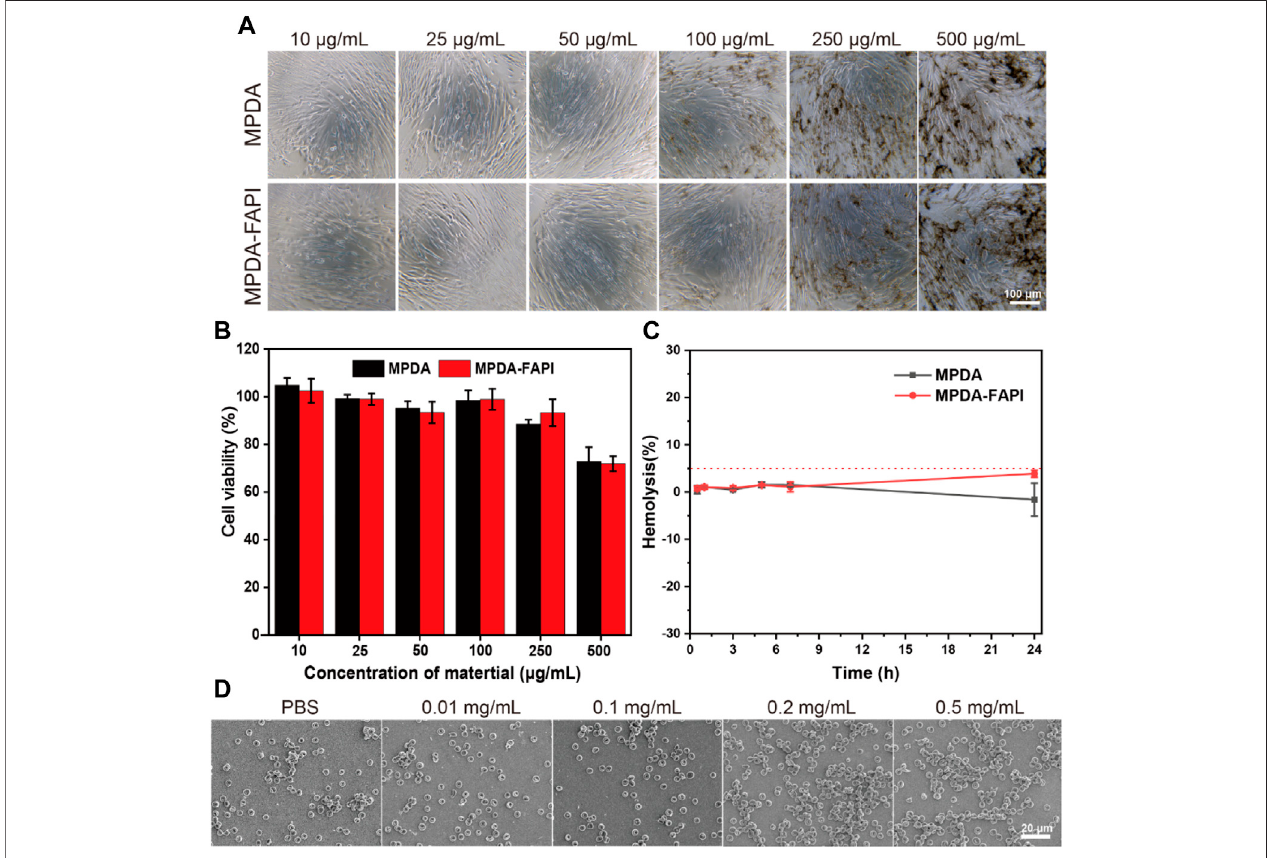
FIGURE 2 | (A,B) Cytotoxicity test of MPDA and MPDA-FAPI NPSs after incubation with HFL1 cells for 24 h. (C) Hemolysis percentage of red blood cells at 0.01 mg/ml of MPDA and MPDA-FAPI. (D) Morphology of red blood cell incubated with MPDA-FAPI.